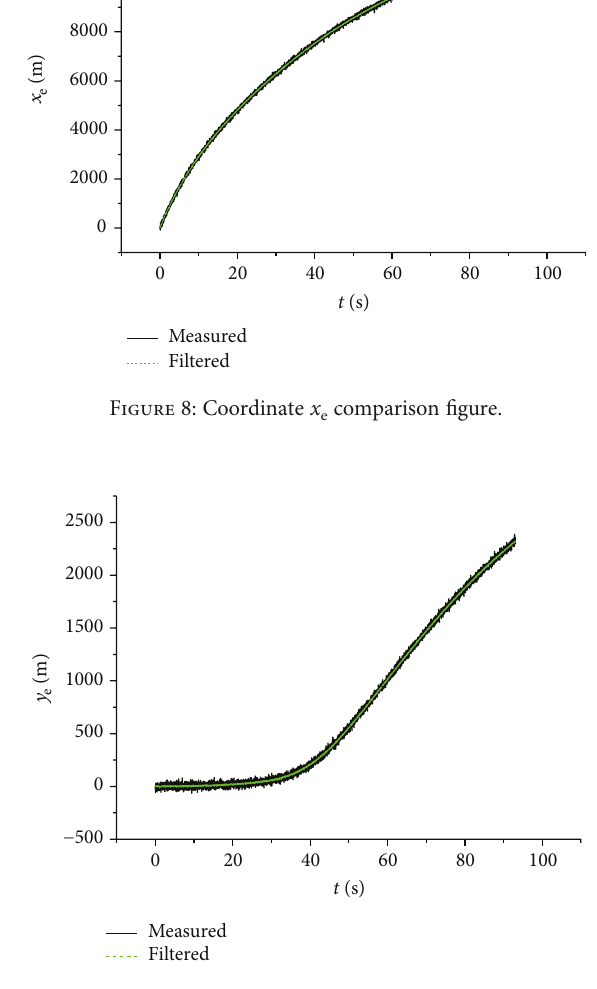
comparison fi e